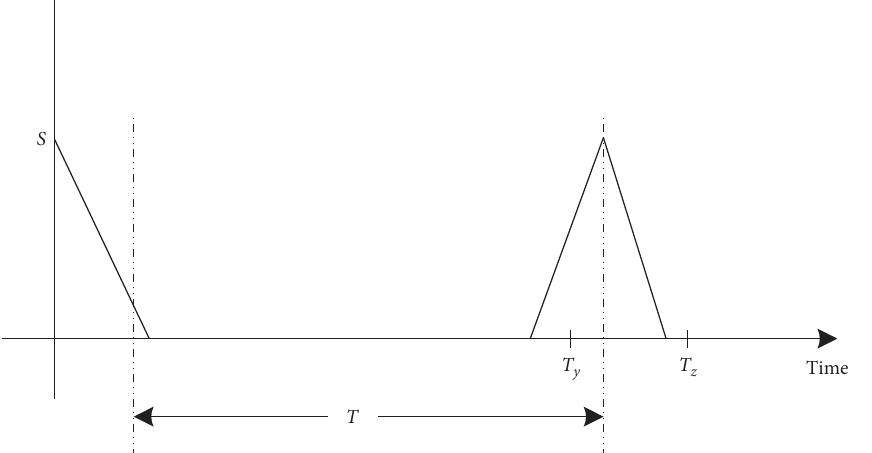
Figure 11: Buffer stock change diagram in a cycle for T